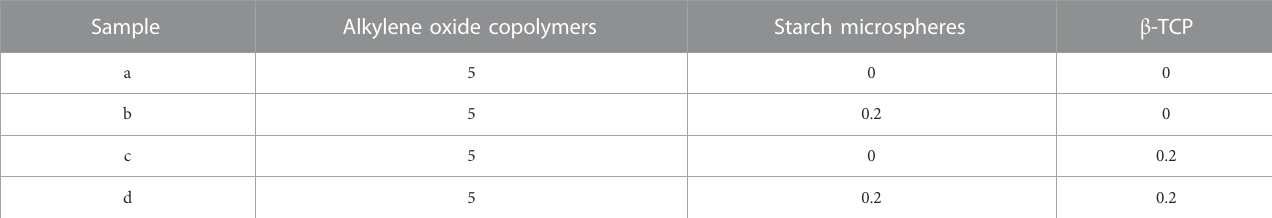
TABLE 1 Different compositions of resorbable bone wax.